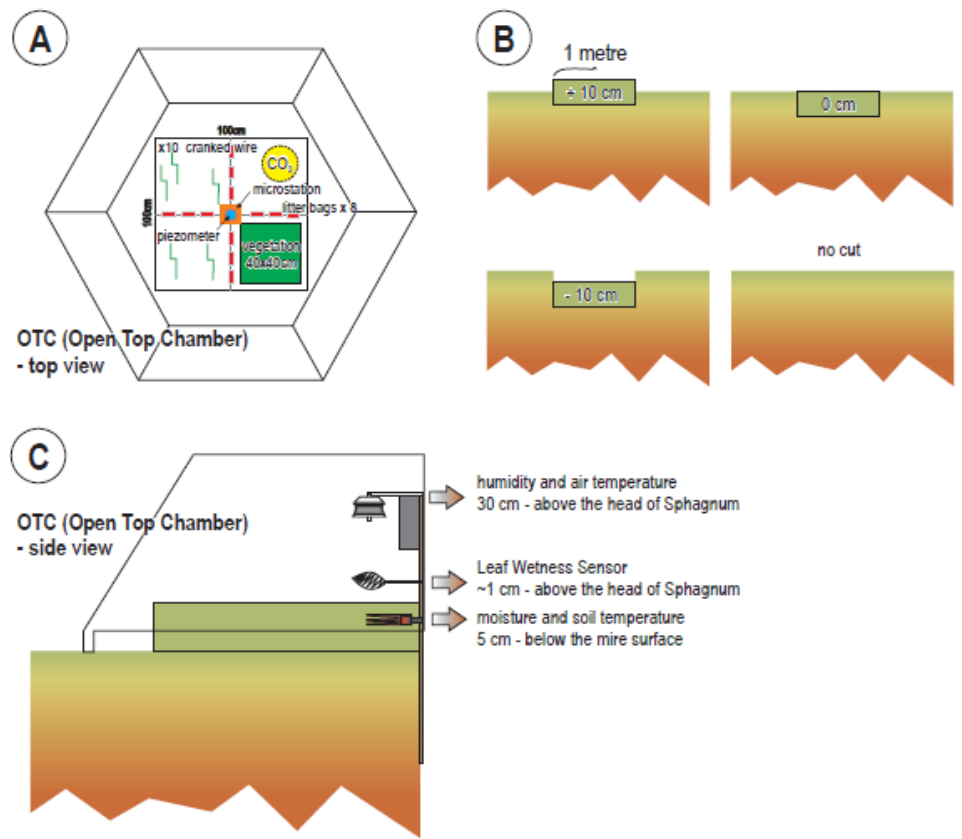
Figure 3. Experimental plot with descriptions of: (A) within-plot space subdivision for the various measurements and sampling; (B) water level manipulation treatments; and (C) environmental monitoring within each